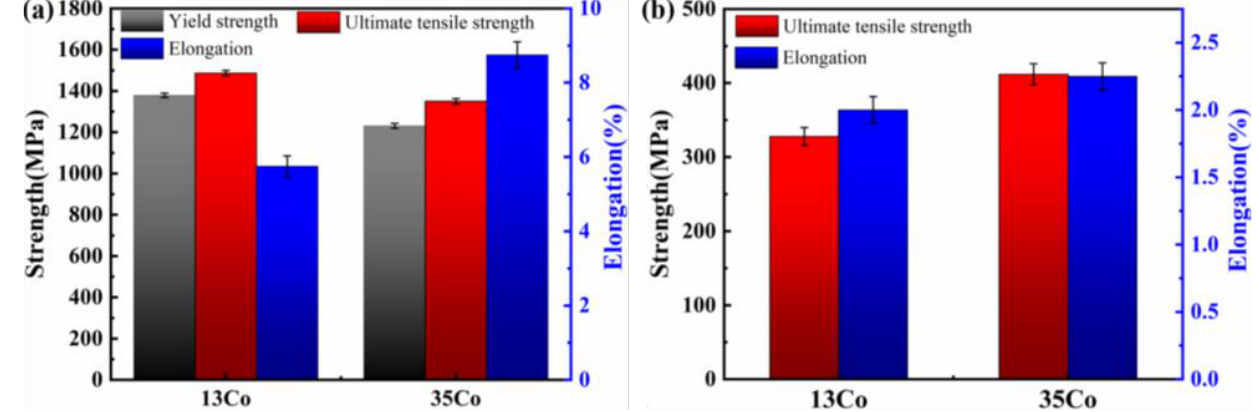
Figure 11. Mechanical properties of the 13Co and 35Co specimens after heat treatment at ( a ) room temperature and ( b ) 850 °C.